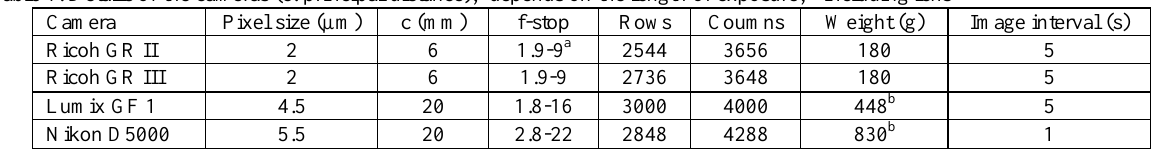
Table 1. Details of the cameras (c: principal distance), a depends on the length of exposure; b including lens Camera